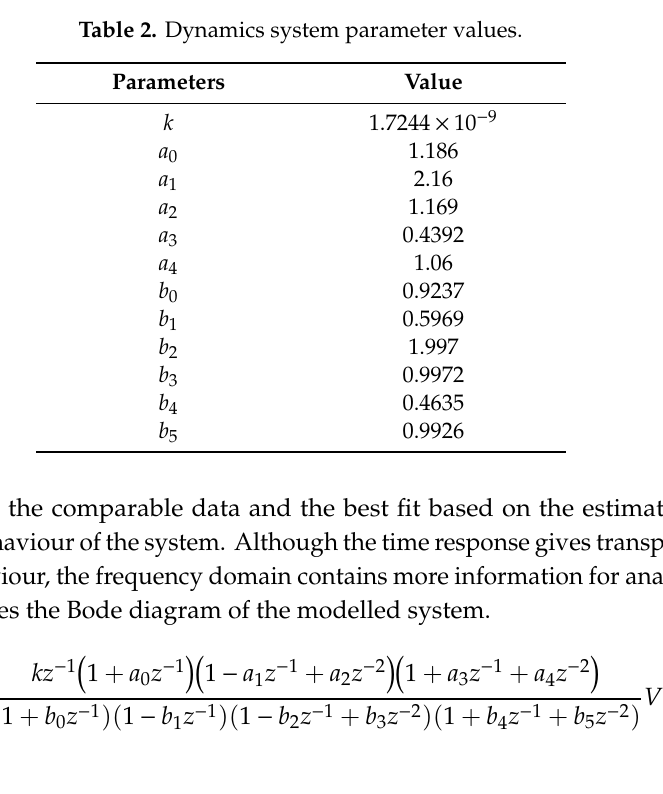
Figure 9. Force needed for crossing through the membrane. This shows the interaction of the force created to cross functionalized carbon nanotubes through the membrane at various velocities between 1 and 2 angstroms per second. This diagram shows an increase in the rate of passage while the crossing velocity is increased. It clearly shows that by increasing the rate of crossing, the interaction forces are increased. The X-axis is the steps, and Y-axis is the force [N]. In this research study, the input system is the impulses that indicate the velocity amplitudes. The system output is the interaction forces derived from the crossing of functionalized CNT through the cell membrane. The order of system is acquired by trial and error with the data and reaching the best fit for the recorded data. In this model, a best fit of 80% with an MSE of around 3 × 10 − 8 was achieved. Equation (2) expresses the transfer function of the system, which is a mathematical relation between the input (velocity) and output (interaction force). The parameters and the values needed for Equation (23) are collected in Tables 1 and 2.